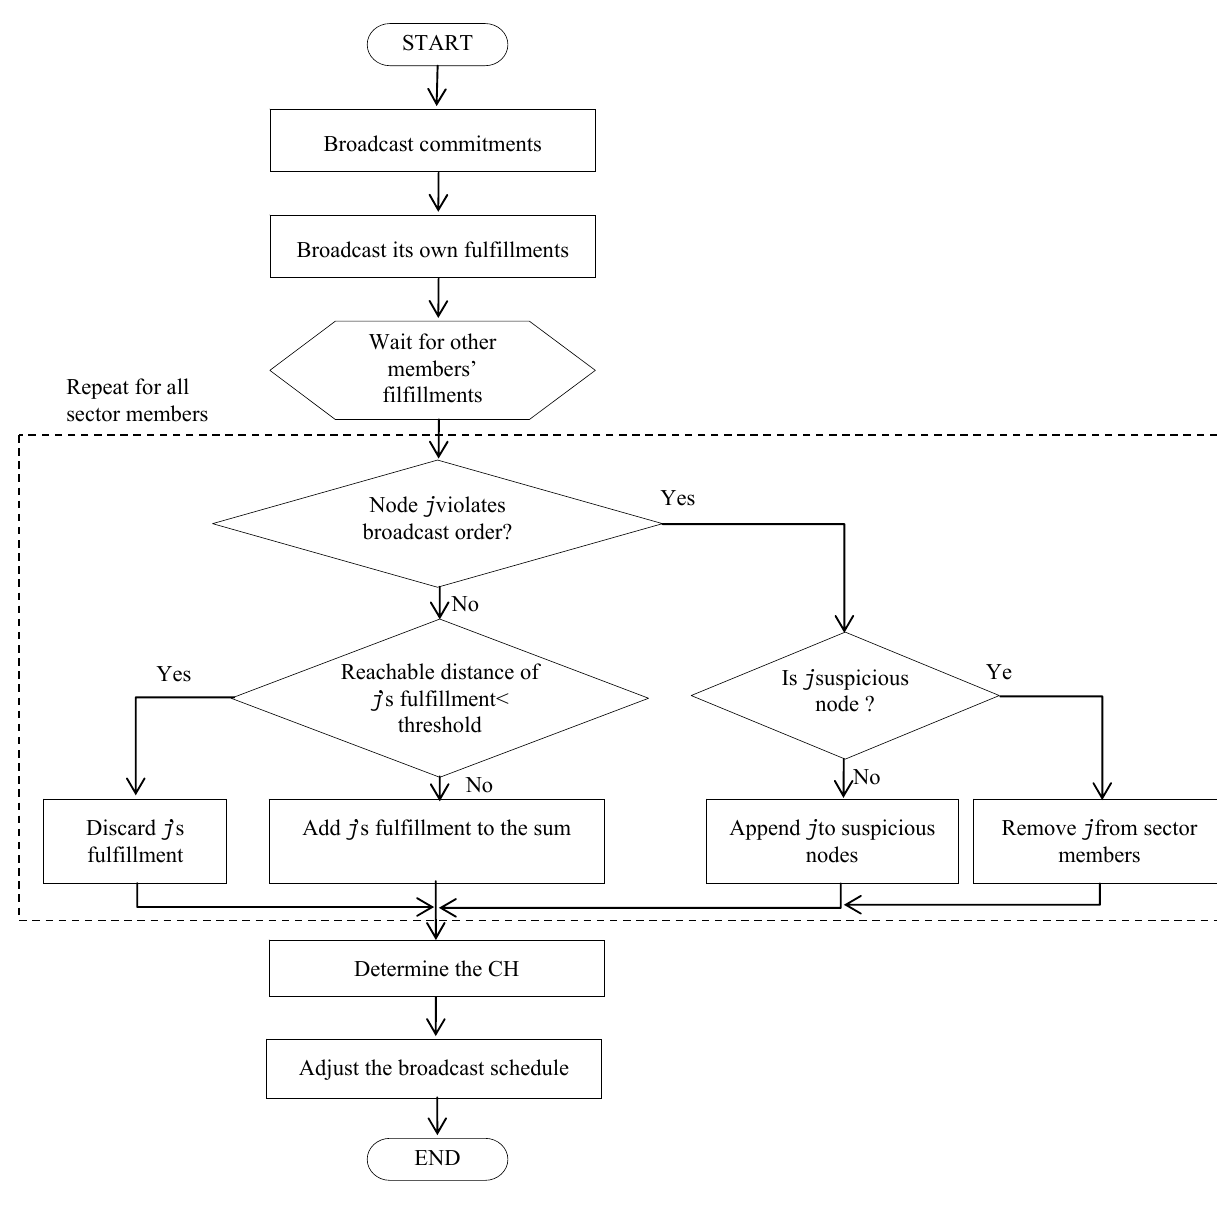
Figure 4. Flow chart of secure cluster head election using signal strength estimation and ordered